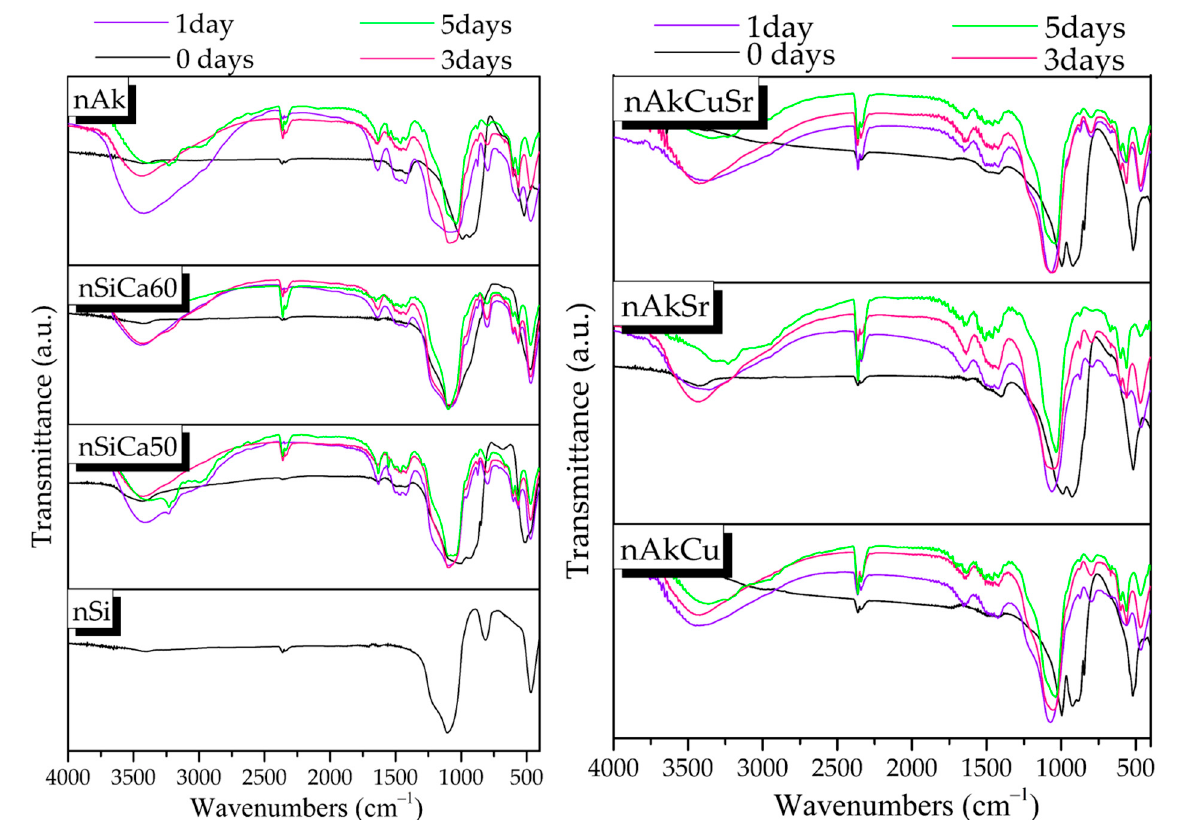
Figure 5. FTIR spectra of the synthesized NPs after 1, 3, and 5 days of immersion in